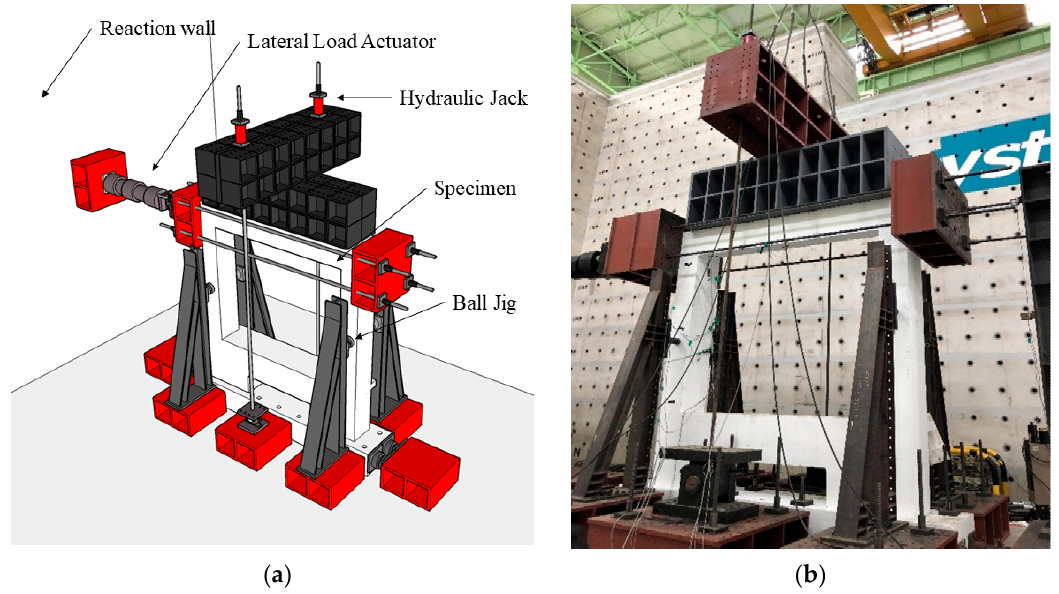
Figure 6. Experimental setup for the cyclic loading test: ( a ) schematic test setup and ( b ) view of the test setup.